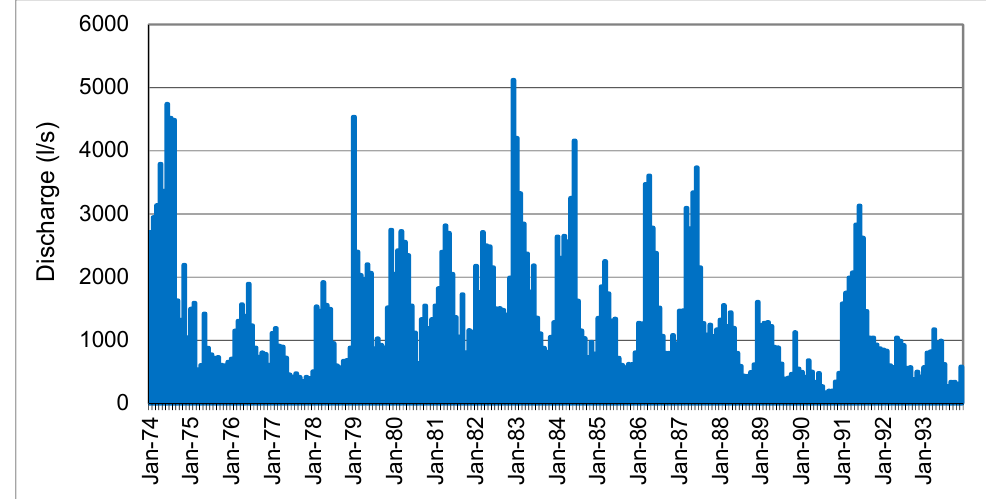
Figure 7. Monthly discharge of Kefalovriso spring.